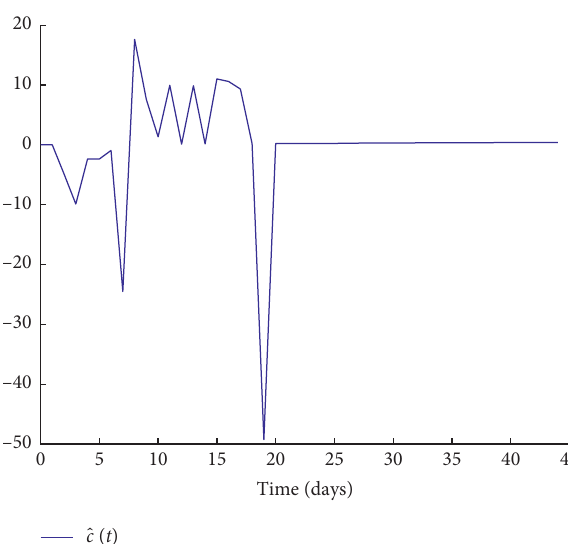
Figure 17: Estimation of β from reported data (Italy) and lsqcurvefit Matlab function.